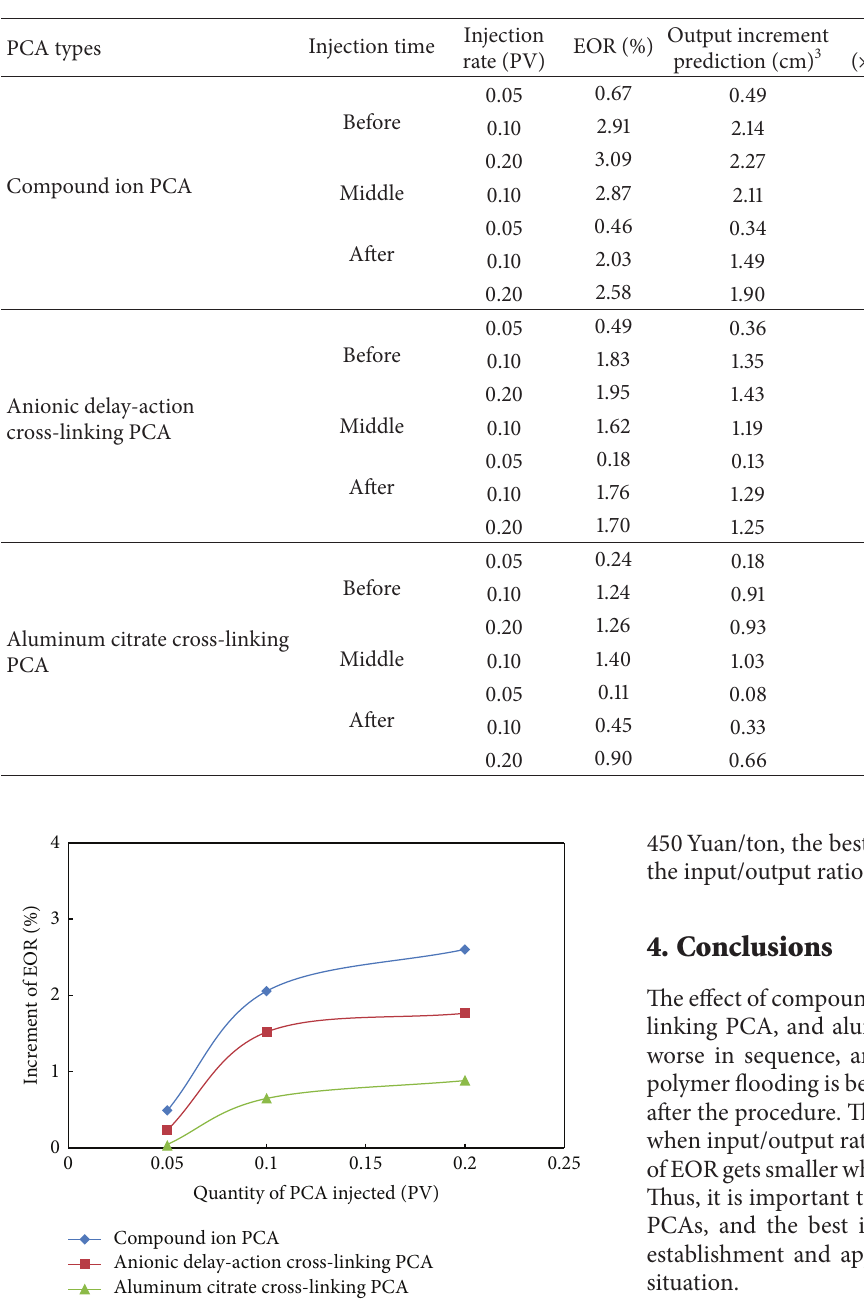
Table 2: Prediction on output increment and economic benefit analysis for different PCA flooding.